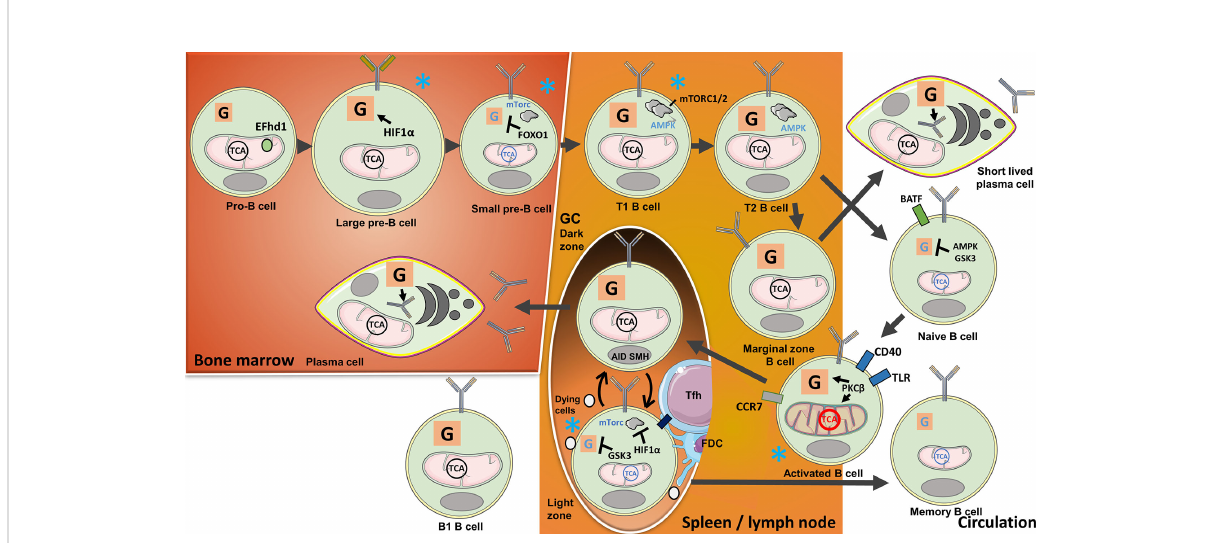
FIGURE 2 B-cell metabolism changes during their development, activation, and purging of clones with no available target antigens or those that are autoreactive. In the bone marrow, metabolism changes during B-cell development with the highest activity at pro-B cell and large B-cell stages: Heavy-chain gene rearrangements during the pro-B cell stage are associated with high DY m, while cell expansion during the large B-cell stage is signi fi ed by increasing glycolytic activity. The mitochondrial Ca 2+ binding EF-hand domain family member D1 (hEFd1) protects pro-B cells from heavy-chain synthesis-induced late surge in Ca 2+ . Large B cells localized to a niche with low O 2 tension upregulate Hypoxia-inducible factor 1 a (HIF1 a ) activating glycolysis during cell expansion. Light-chain gene arrangements and removal of self-reactive clones during the small pre-B-cell and immature B-cell stages are, in contrast, associated with suppressed mechanistic target of rapamycin 1(mTORC1) and low metabolic activity controlled by Forkhead box protein O1(FOXO1). Transitional (T) B cells again have high metabolic activity, OXPHOS, and mTORC1/2. Residual autoreactive clones are removed when the cells locate to the spleen and transition from T1 to T2 stage. Naive and Marginal zone (MZ) B cells develop from T2 B cells. Naive B cells found in the circulation have low metabolic activity regulated by AMP- activated protein kinase (AMPK) and Glycogen synthase kinase-3 (GSK3). Tonic B cell receptor (BCR) signaling and B-cell activating factor (BAFF) receptor engagement provide survival signals. When naive B cells encounter antigens, the cells are activated and undergo metabolic changes with the expansion of mitochondria guided by Protein kinase C b (PKC b ). Activated B cells will migrate to lymph nodes and the spleen, requiring T-cell help or Toll like receptor (TLR) stimulation for survival. T cell-stimulated B cells locate to B-cell follicles to initiate Germinal centre (GC) reactions. Highly metabolically active B cells proliferate in the Dark zone (DZ) and undergo activation-induced cytidine deaminase (AID)-guided somatic hypermutations (SHM). The cells subsequently move to the Light zone (LZ), where HIF1 a , induced by low O 2 tension, suppresses mTORC1, while GSK3 suppresses glycolysis. The cells compete for selection by follicular T cells (Tfh) cells and follicular dendritic cells (FDCs) in the LZ. Selected cells utilize lipids from unselected counterparts for anaplerosis. The cells can reenter the DZ for further selection, or leave the GC, in the latter case either differentiating to long-lived plasma cells (LLPC) or memory B cells. LLPCs with high metabolic activity will locate to the bone marrow, there producing antibodies. Glycolysis provides a substrate for glycosylation of antibodies. Circulating memory B cells, on the other hand, are signi fi ed by low metabolic activity. MZ B cells, another progeny of transitional B cells, develop into short-lived plasma cells with a metabolic signature similar to LLPCs, independently of GC reactions. B1 cells developing in the embryo are signi fi ed by high glycolysis and OXPHOS. Blue stars indicate B-cell stages where clones with low antigen speci fi city or self-reactivity are